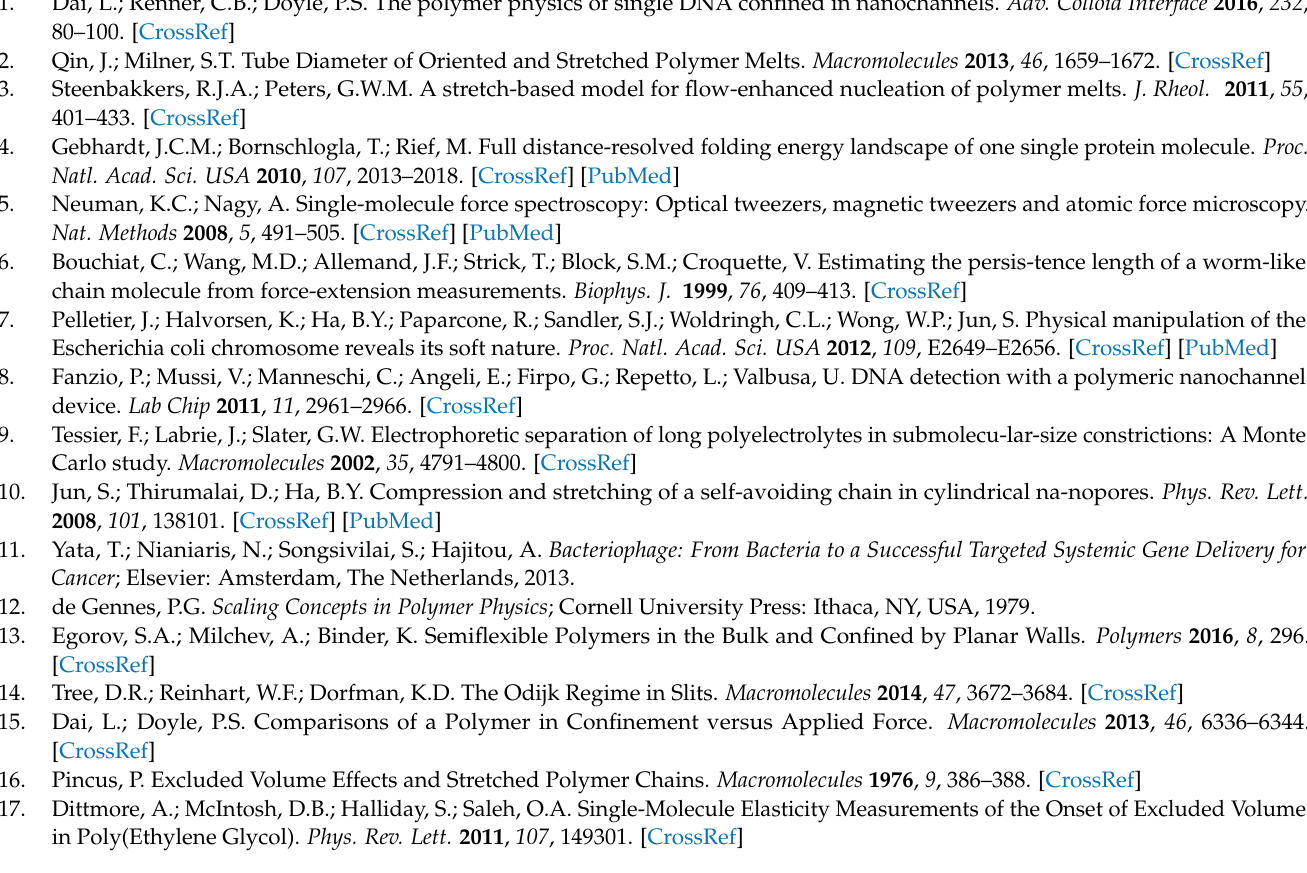
Figure S2: Compression processes of semiflexible linear and ring polymers ( Lp = 5.0 ) in microchan- nel confinement ( d = 5 ) under the external force f = 1.0. Figure S3: The length along the tube L x and the thickness δ as a function of time t for linear and ring polymers with different rigidities under the external force f = 1.0. Figure S4: The trajectory of the length along the tube L x for linear and ring polymers under different magnitude of external